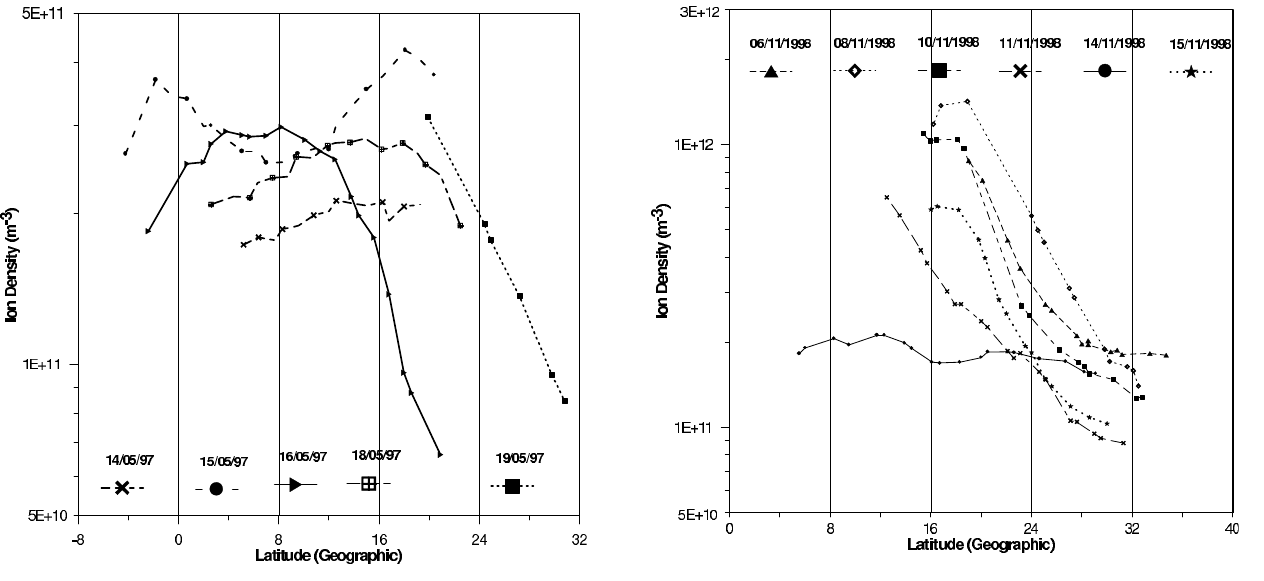
Fig. 2. Latitudinal variation of ion density observations made by the SROSS-C2 satellite during the period of storm I. The longitude range covered by each pass is given in Table 2.